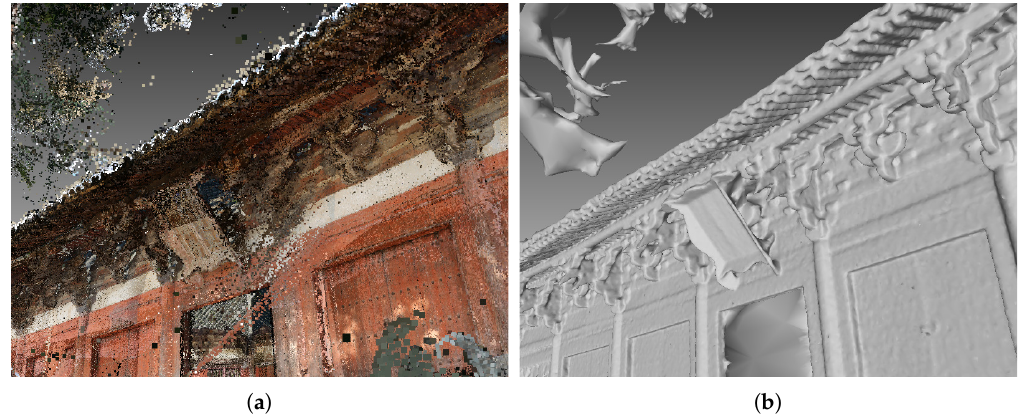
Figure 1. An example of the application of the proposed method in the field of cultural heritage digitalization, ( a ) point cloud; ( b )